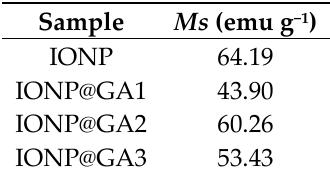
Figure 6. Magnetic hysteresis loops of IONP@GA. Table 1. Saturation magnetizations of IONPs.